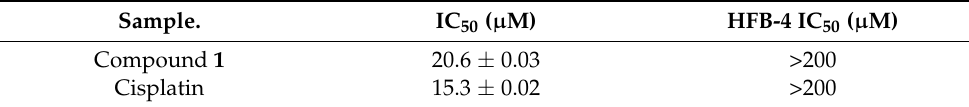
Table 3. IC 50 of compound 1 on the breast cancer cell line (MCF-7). Sample.